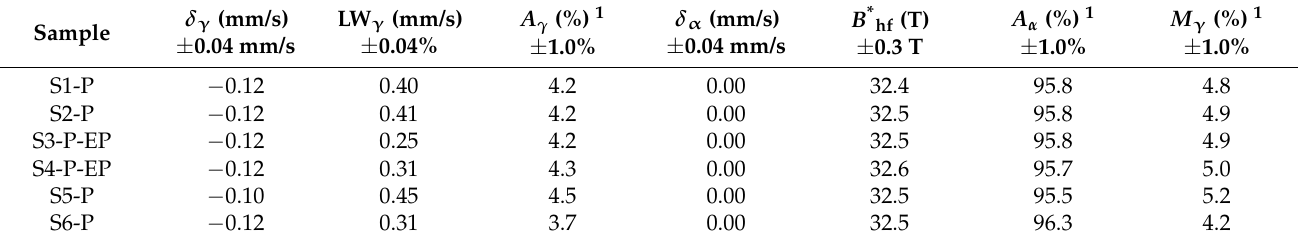
Table 4. Austenite and martensite contents in secondary samples resulting from Mössbauer spec- troscopy analysis, where δ γ and δ α is isomer shift of austenite and martensite pattern resp., LW γ is a line width of austenite, A γ is a relative area of austenite in the spectrum, B * hf is an average hyperfine field of the martensite subspectrum, A α is a relative area of martensite in the spectrum, M γ is the amount of retained austenite according to Equation